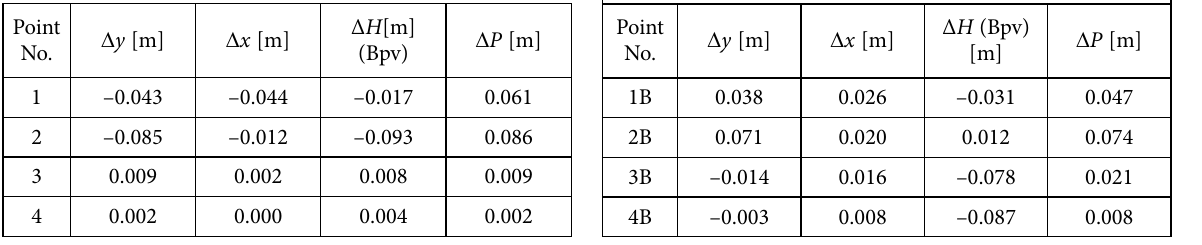
Table 2. Difference between the 1st and 2nd measurements